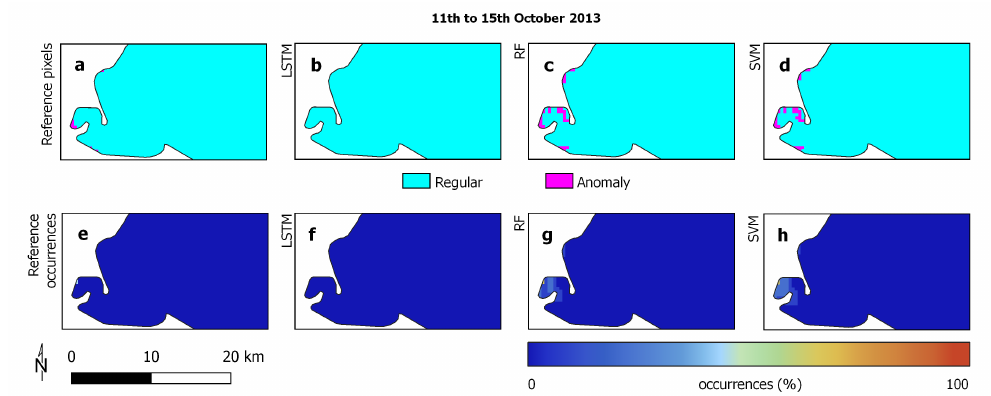
Figure 12. Period trend forecasting based on pixels ( a – d ) and occurrences ( e – h ) from 11–15 October 2013, related to Lake Erie. Plots ( a , b ) represent the mapping of the reference